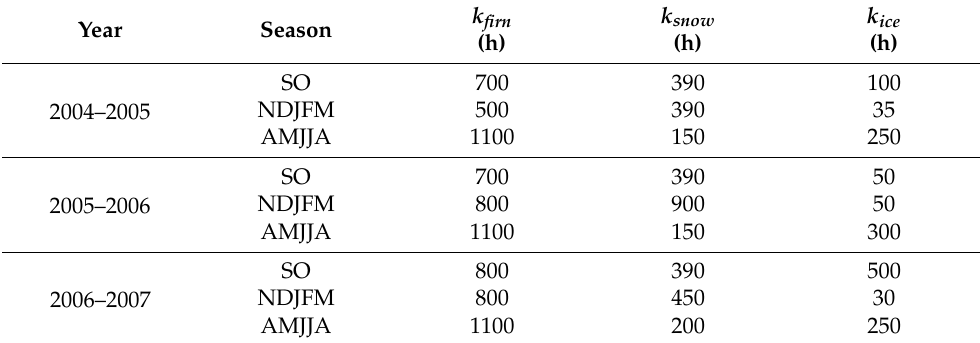
Table 5. Optimally calibrated seasonal storage constants for the three kinds of glacier